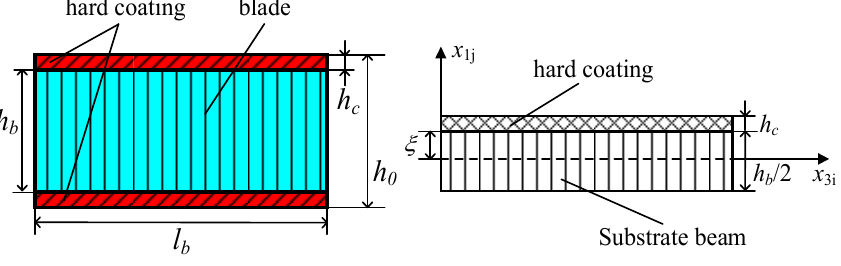
Figure 2. Schematic figure of the hard ‐ coated beam.